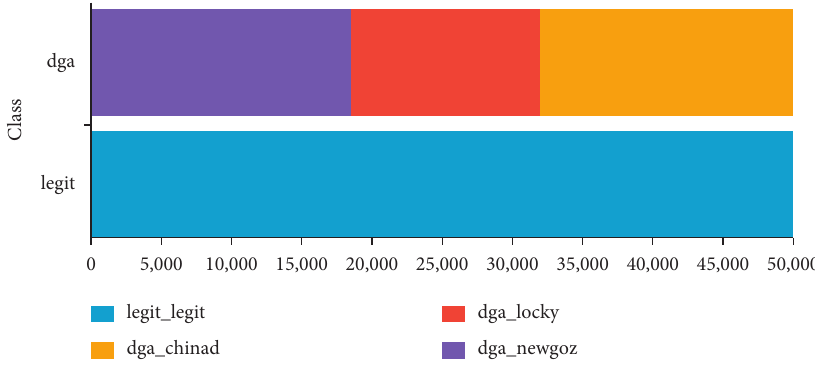
Figure 2: Comparative chart of locky, newgoz, chinad botnets, and legit data.